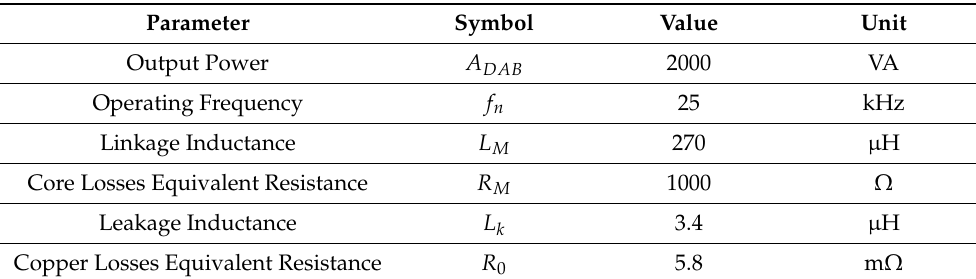
Table 4. Equivalent circuit DAB transformer parameters.